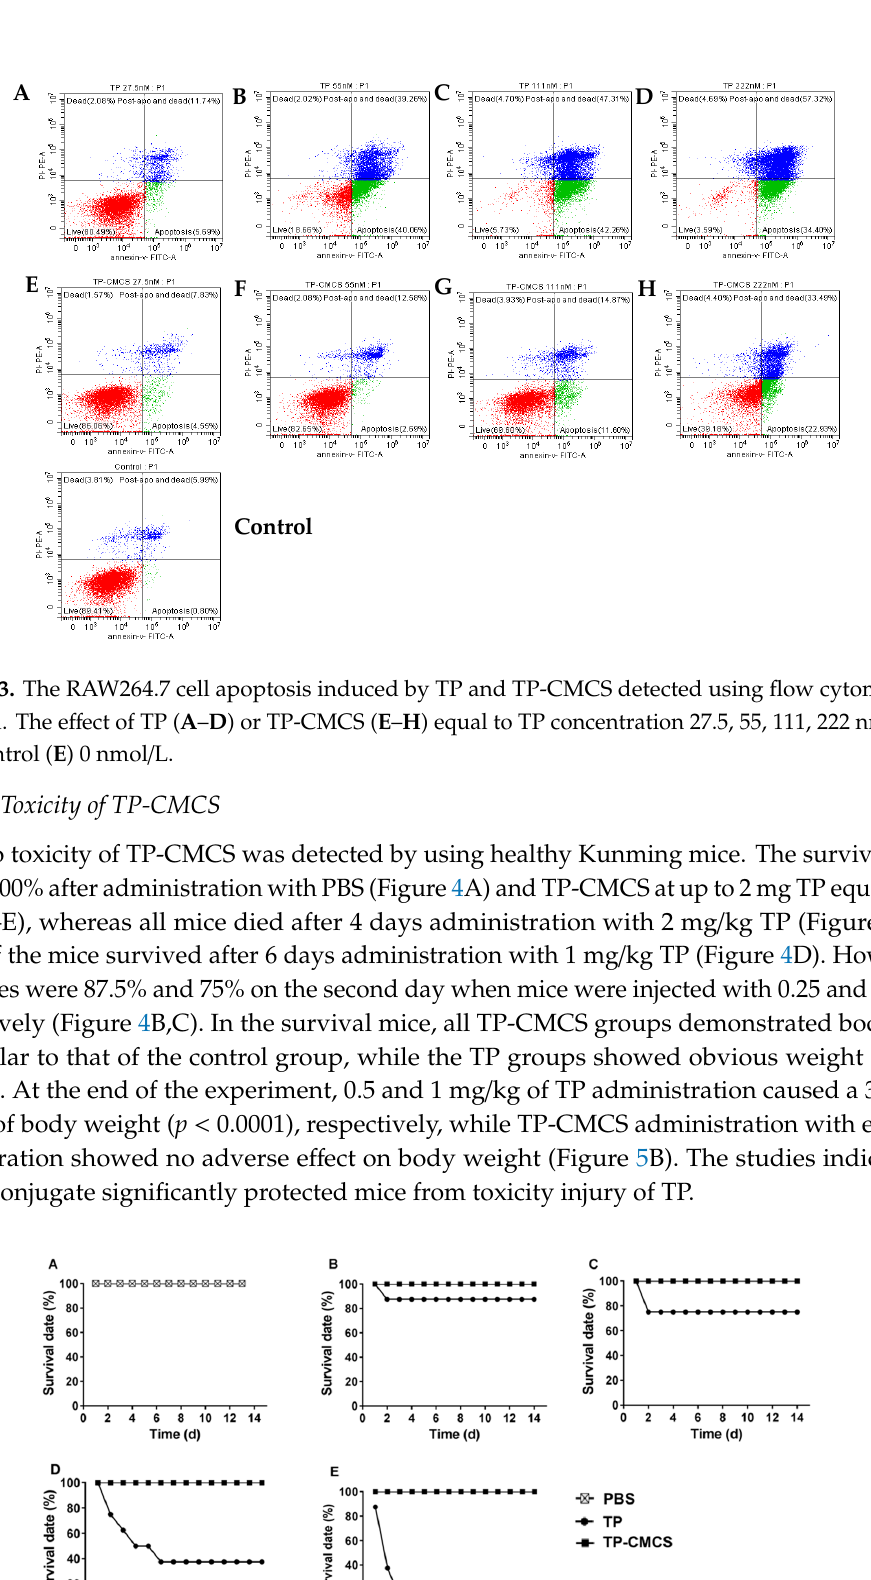
Figure 4. Survival rate of mice receiving TP and TP-CMCS by tail vein injection. Rate of mice after tail vein injection of PBS ( A ), TP vs TP-CMCS, 0.25 mg TP equivalent/kg ( B ), 0.5 mg TP equivalent/kg ( C ), 1 mg TP equivalent/kg ( D ), 2 mg TP equivalent/kg ( E ).